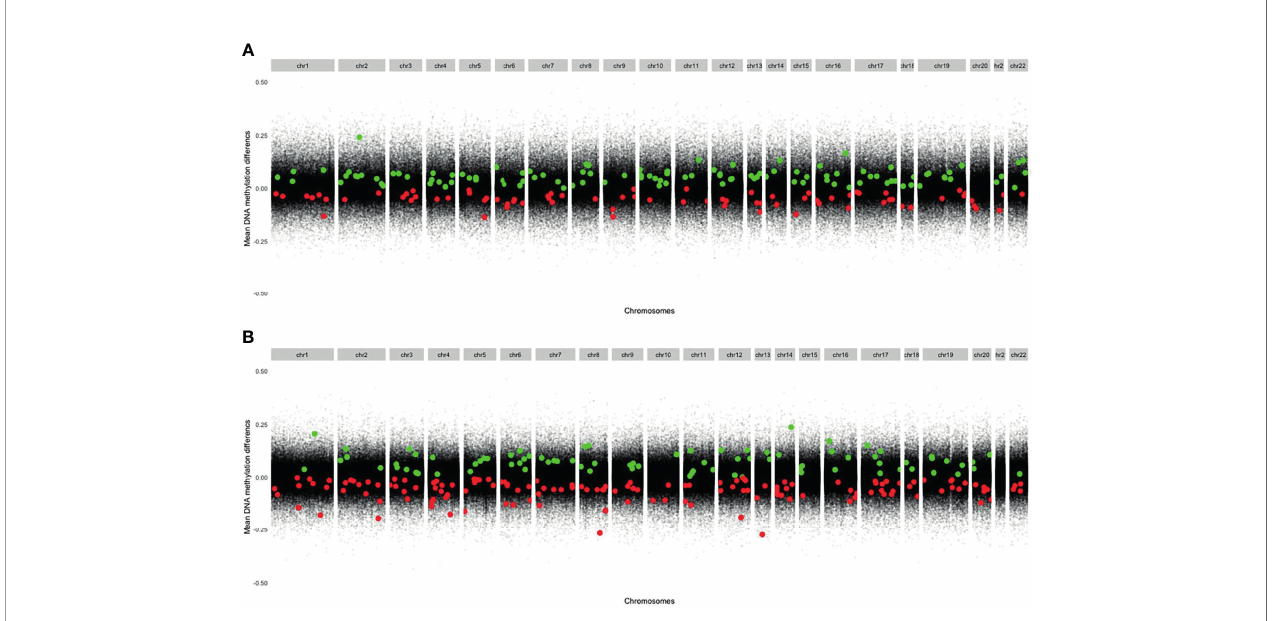
FIGURE 2 | Modi fi ed Manhattan plots showing mean DNA methylation differences on the y-axis and genomic positions on the x-axis. Green dots represent signi fi cant DMPs with increased DNA methylation at follow-up. Red dots represent signi fi cant DMPs with decreased DNA methylation at follow-up. (A) CD4 + memory T cells (Increased DNA methylation: 111 DMPs. Decreased DNA methylation: 77 DMPs). (B) CD4 + naïve T cells (Increased DNA methylation: 84 DMPs. Decreased DNA methylation: 142 DMPs). DMPs, Differentially methylated